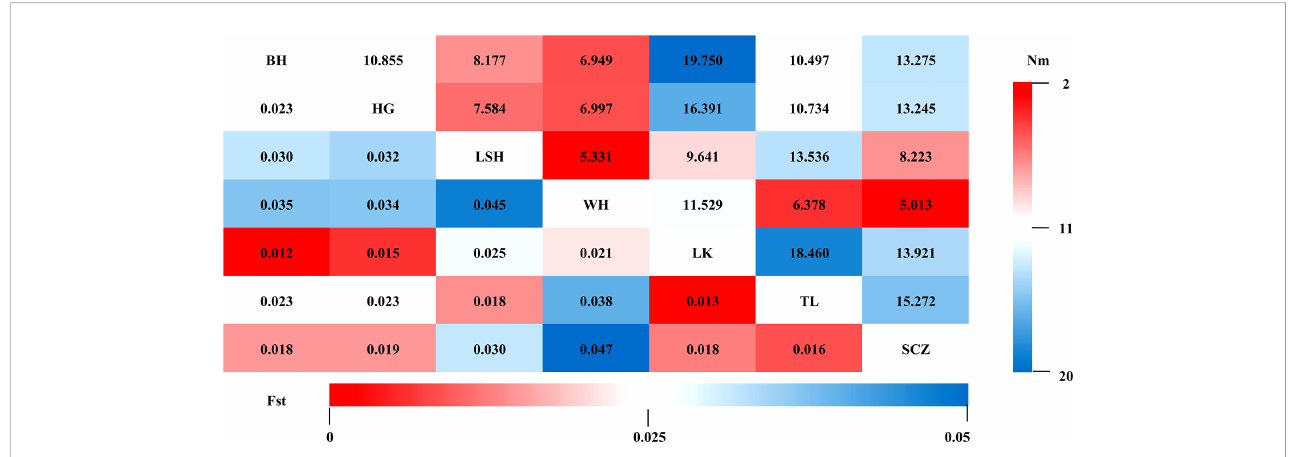
FIGURE 2 Genetic differentiation coef fi cients (lower left) and gene fl ow (upper right) between populations. (BH, Bohai; HG, Hegang; LSH, Lushuihe; WH, Weihe; LK, Linkou; TL, Tieli; SCZ,